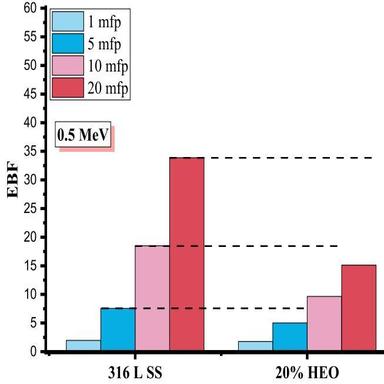
Change of (a) EABFs and (b) EBFs with several penetration depths for 316 L SS and 20 % HEO samples at fixed 0.5 MeV photon energy.